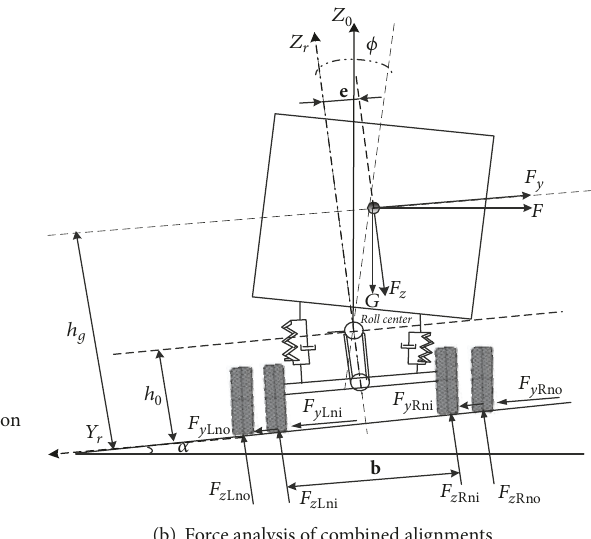
Figure 5: Force analysis of tractor-semitrailer cornering on combined